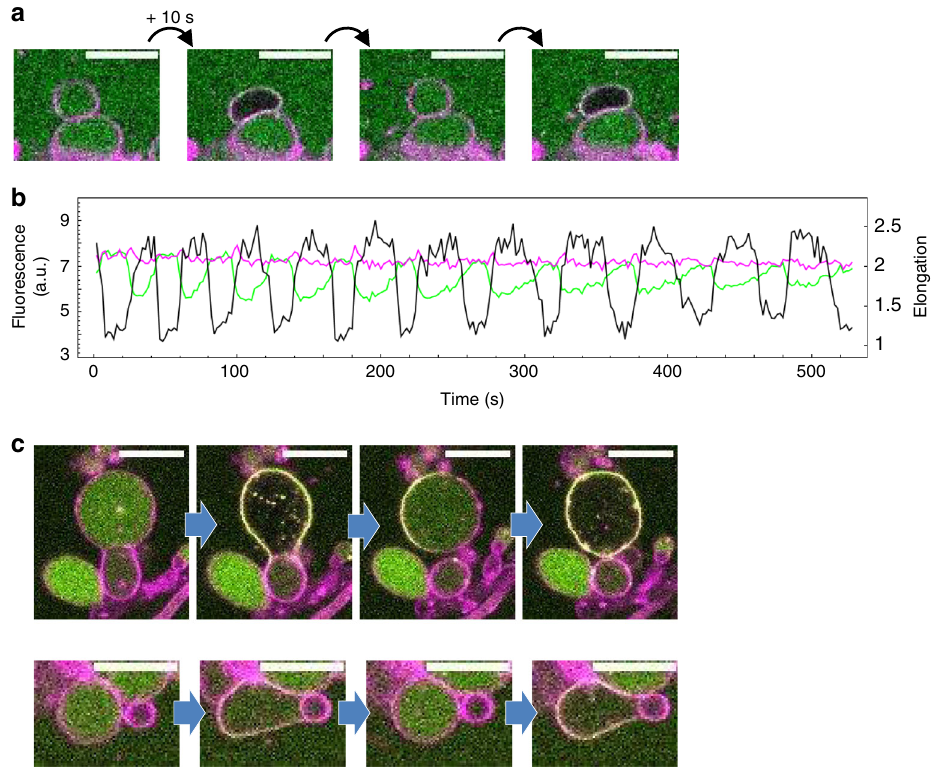
Fig. 5 Autonomous liposome deformation induced by synthetic Min oscillations. a Time-series images of a liposome that changes morphology in response to Min oscillations. The membrane dye signal is colored in magenta and the eGFP-MinC reporting the waves is in green. The corresponding movie is shown in Supplementary Movie 8. Scale bars are 10 µ m. b Fluorescence time traces of the eGFP-MinC intensity localized at the membrane (magenta) and in the lumen (green) of the liposome displayed in a . The time pro fi le of the liposome elongation is overlaid in black and is phase shifted with respect to the amount of eGFP-MinC in the lumen. c Time-lapse fl uorescence images of two liposomes exposed to a hypertonic external medium (100 mM sucrose). Liposomes undergo dramatic shape deformation upon recruitment of Min proteins to the inner surface of the lipid bilayer. The force generated by the redistribution of the Min proteins is suf fi cient to push a membrane septum and remodel adjacent vesicles. The corresponding videos are shown in Supplementary Movie 9. Scale bars are 10 µ